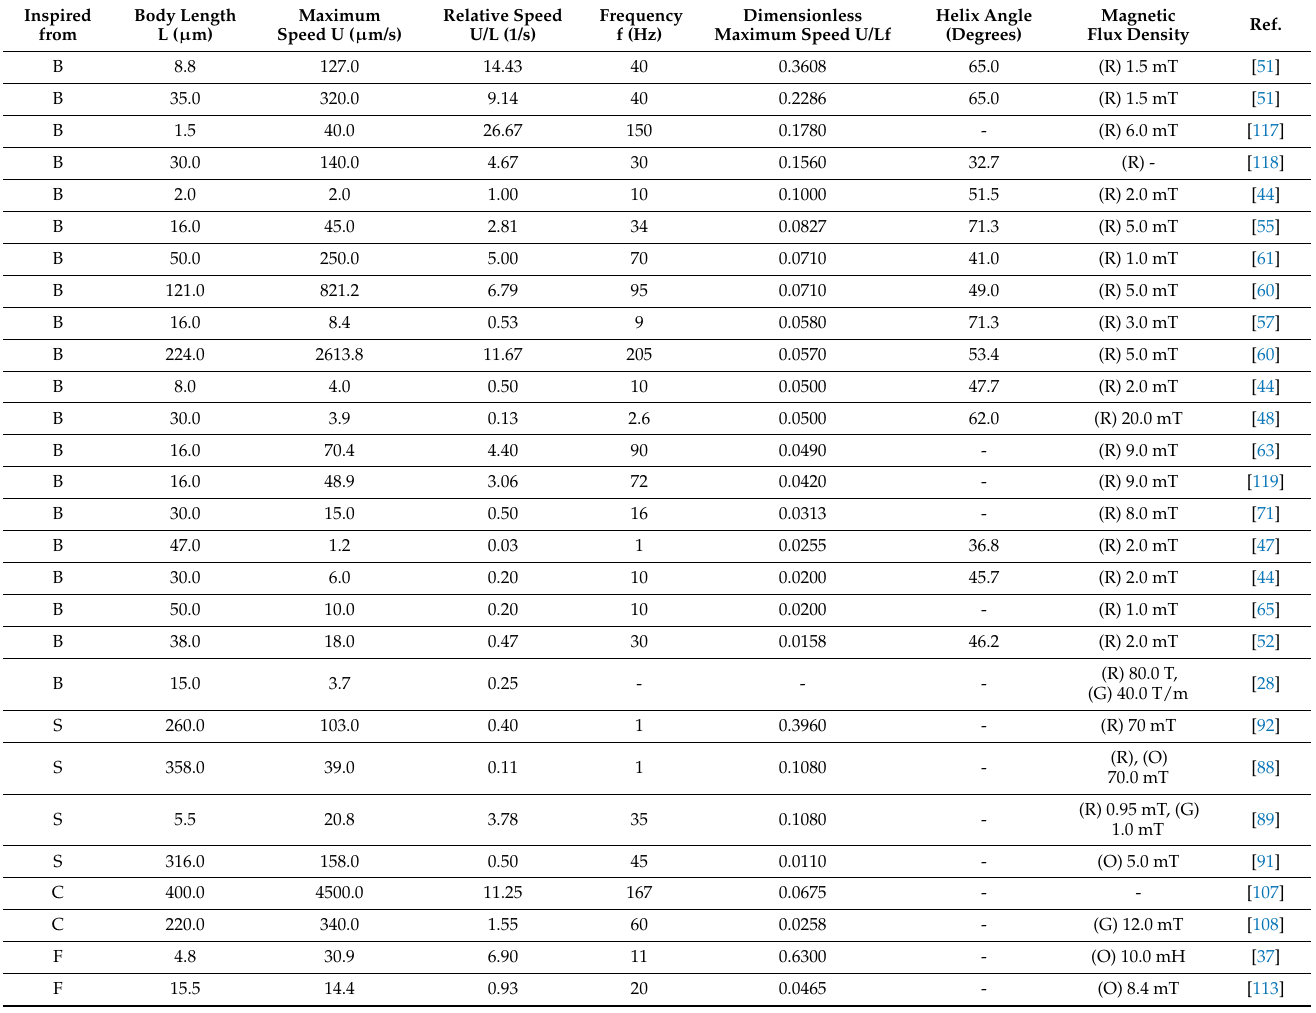
Table 2. Important parameters of bio-inspired magnetically actuated